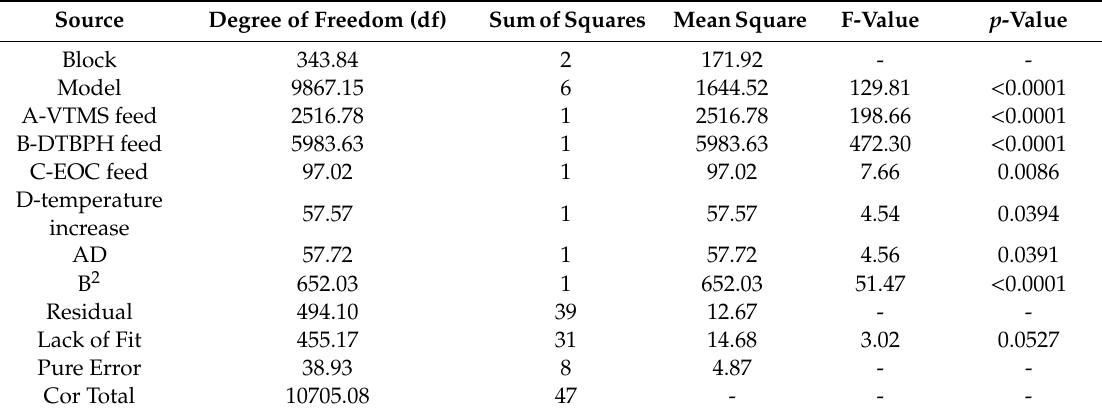
Table 5. Analysis of variance (ANOVA) for response surface analysis of grafting e ffi